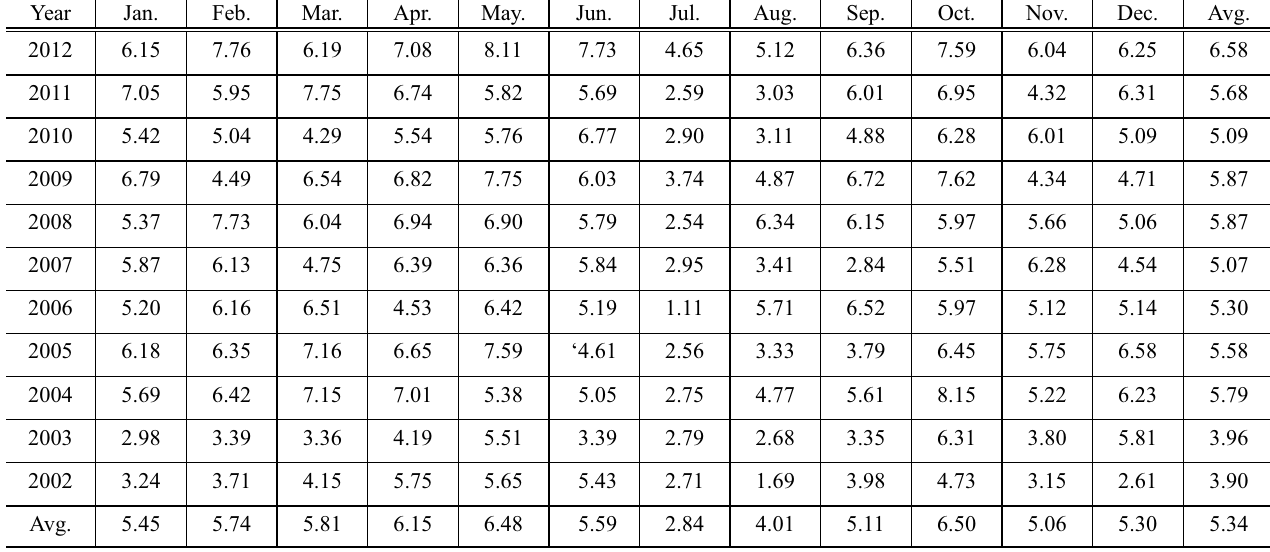
Table 3 Monthly mean sunlight exposure time at Seoul,